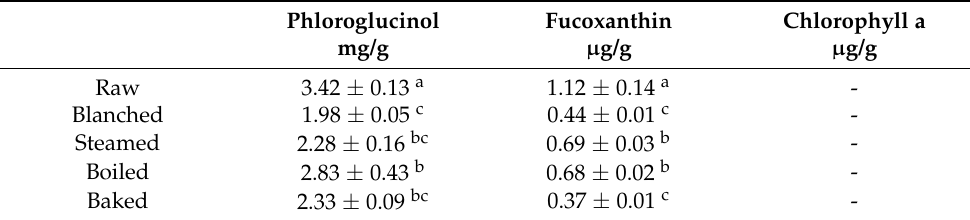
Table 2. Effects of different processing methods on the contents of polyphenols, fucoxanthin, and chlorophyll in L. japonica